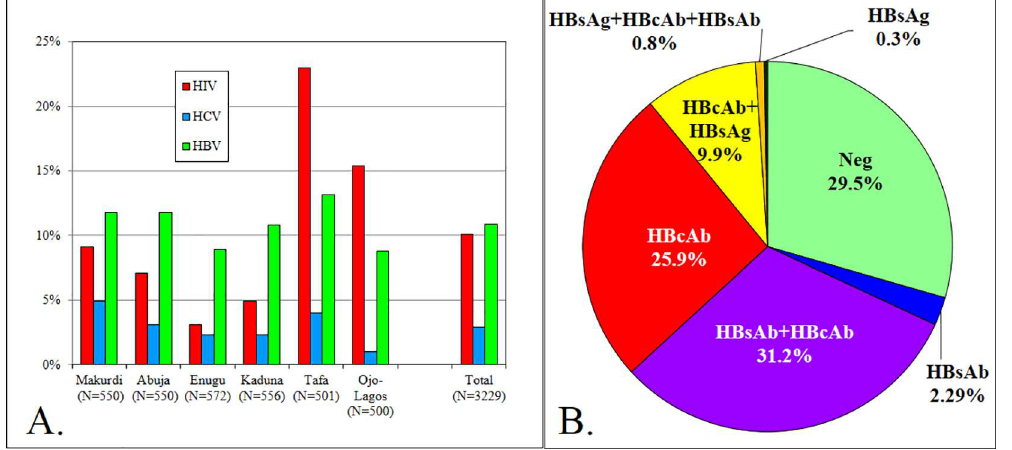
Fig 1. Distribution of HIV, HCV and HBV infections among 3229 volunteers tested. A. Percent HIV, HCV and HBV infectionsat each site. B. Distributionof HBV markers in populationstudied. 68.8% of the populationwas positive for at least one marker of HBV